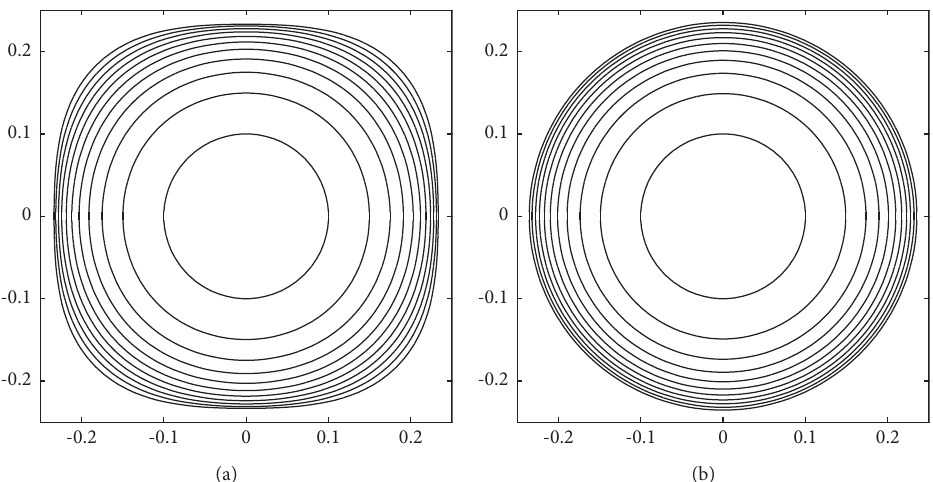
Figure 2: (a, b) Zero-level contours for the circular evolution in equation (12) with standard and isotropic schemes up to t � 1200 Δ t at every 120 Δ t ,